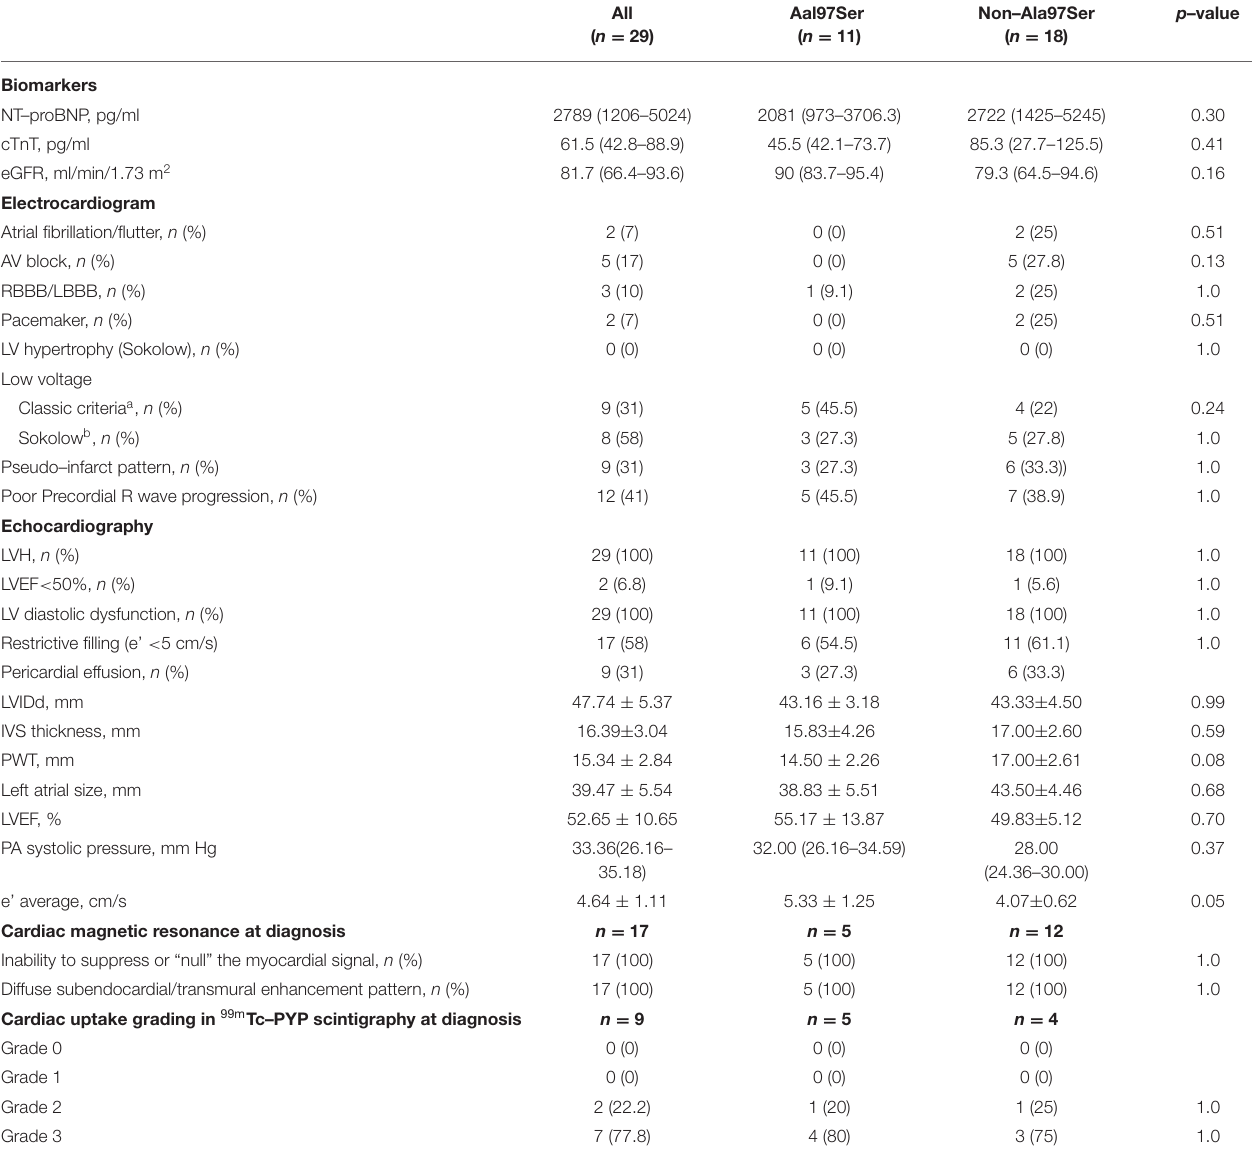
TABLE 2 | Complementary baseline tests for ATTRv–CM and the TTR variant